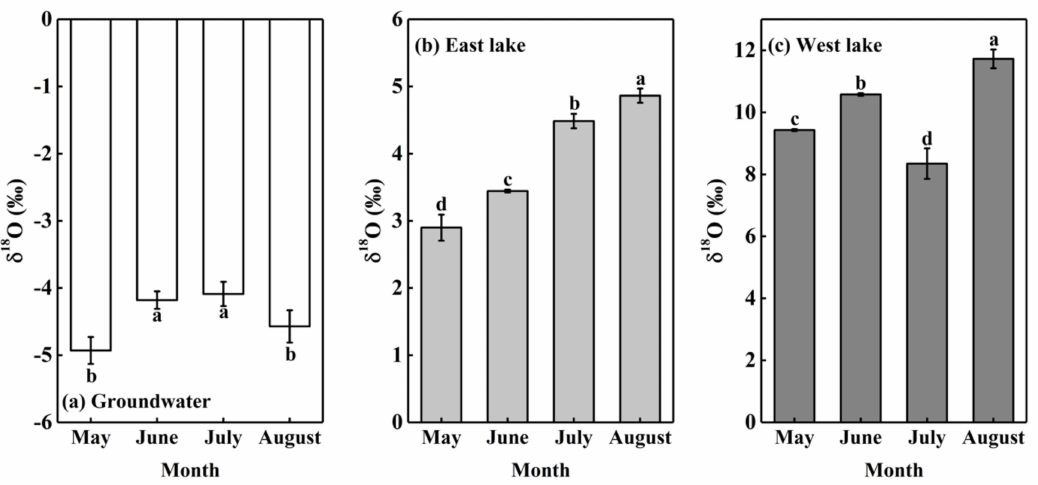
Figure 4. Seasonal variations in δ 18 O values of groundwater and lake water. Data are expressed as means ± 1SD. Different lowercase letters express significant differences for δ 18 O values of groundwa- ter and lake water among months at significance level p <